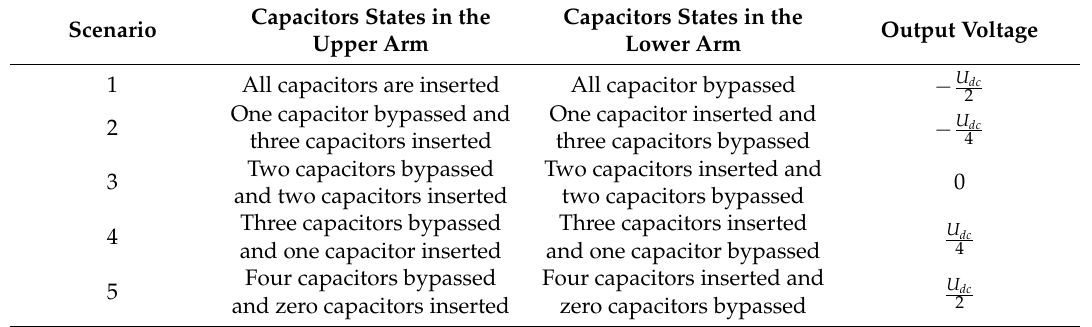
Table 1. Capacitor